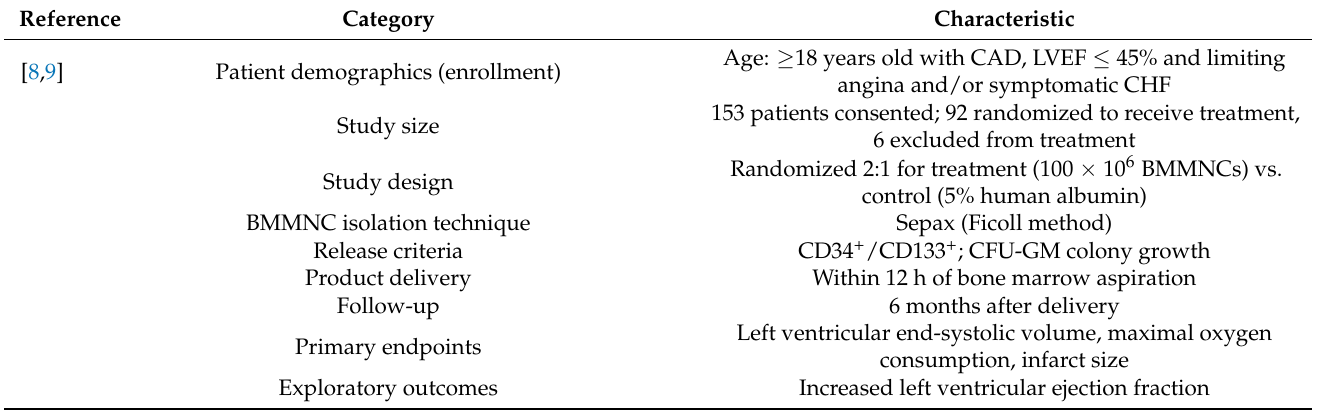
Table 2. FOCUS-CCTRN trial: Patient demographics, study design, and clinical